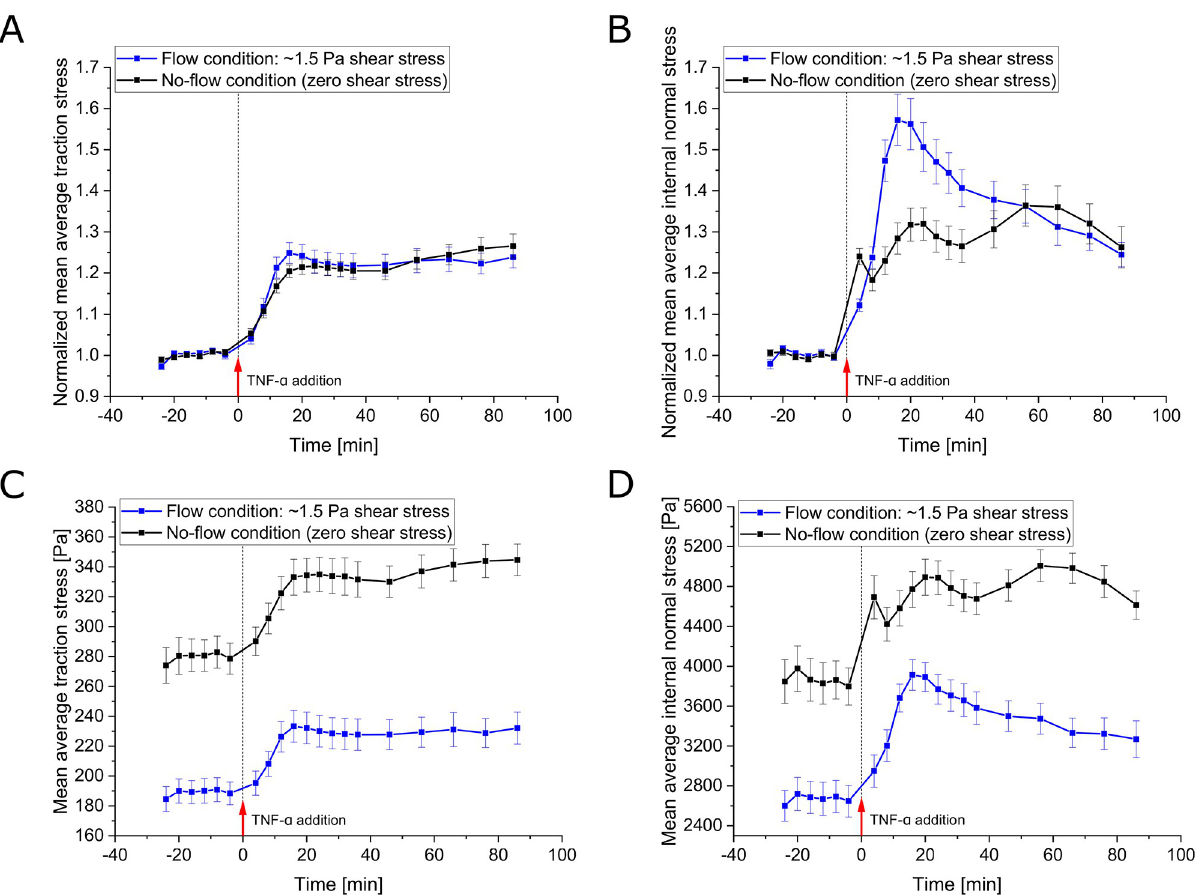
Fig 4. HUVECs’ mechanical response upon TNF- α exposure in flow (1.5 Pa shear stress) and no-flow (zero shear stress) conditions. A,B : Time course of the mean of spatially averaged (A) traction stress and (B) internal normal stress of multiple monolayer islands recorded at baseline and upon 20 ng/ml TNF- α treatment. Data is shown as mean ± SEM and has been normalized to the mean of the first 6 time points recorded prior to cytokine administration for each individual monolayer island ( n = 35, N = 3 under the condition of flow-induced shear stress; for the no-flow condition data are the same as in Fig 3A and 3B). The time course of the average traction stress in response to TNF- α under flow conditions closely follows the one observed in the case of no flow, with the exception of a slight overshoot of peak values. The initial steep rise with a subsequent intermediate drop in internal normal stress is, as expected, absent in the presence of constant fluid flow. Interestingly, the level of the actual peak reached in response to TNF- α is significantly higher than in the situation without applied flow ( p = 0.0022 at 20 min peak). C,D : Same as in A,B, respectively, but the averages of absolute stress values are shown instead of normalized data. The absolute stress values are substantially lower in the presence of fluid flow-induced shear stress. Even after the higher relative increase in internal normal stress in response to TNF- α , values do not exceed those observed for the no-flow condition; in fact, the maximum levels only reach the baseline levels observed in the no-flow